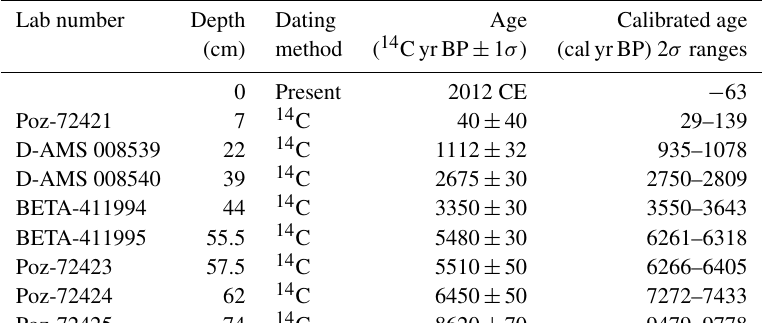
Table 1. Age data for LH 12-03. All ages were calibrated using IntCal13 curve (Reimer et al., 2013) with Clam program (Blaauw, 2010; version 2.2).